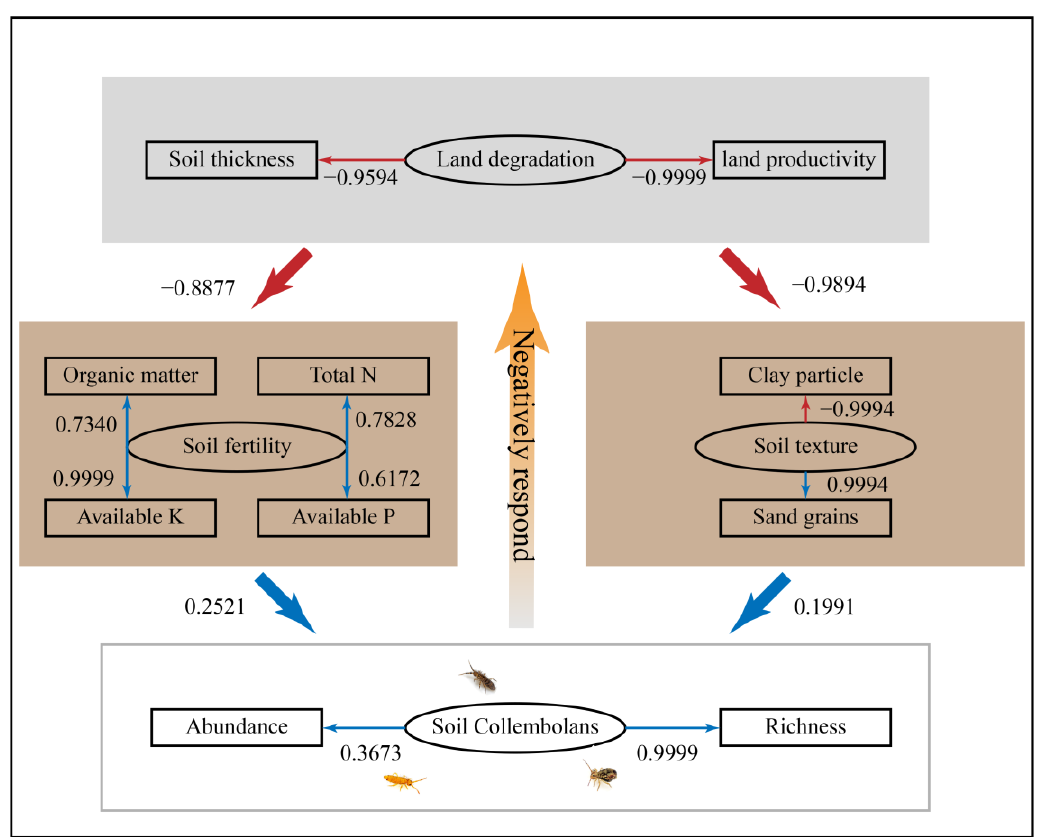
Figure 6. Structural equation model relating land degradation, soil fertility, soil texture and soil Collembolan communities (χ 2 / df = 2.145, p = 0.365, GFI = 0.907, CFI = 0.919 and RMSEA = 0.017). The rectangles represent the observed variables (soil organic matter, total N, available P, available K, clay particles, sand grains, soil thickness, land productivity (yield of maize), abundance and richness); the ovals represent latent variables (land degradation, soil fertility, soil texture and soil Collembolan communities). The red arrows indicate a negative correlation between each variable; the blue arrows indicate a positive correlation between each variable. The numbers indicate regression weights.